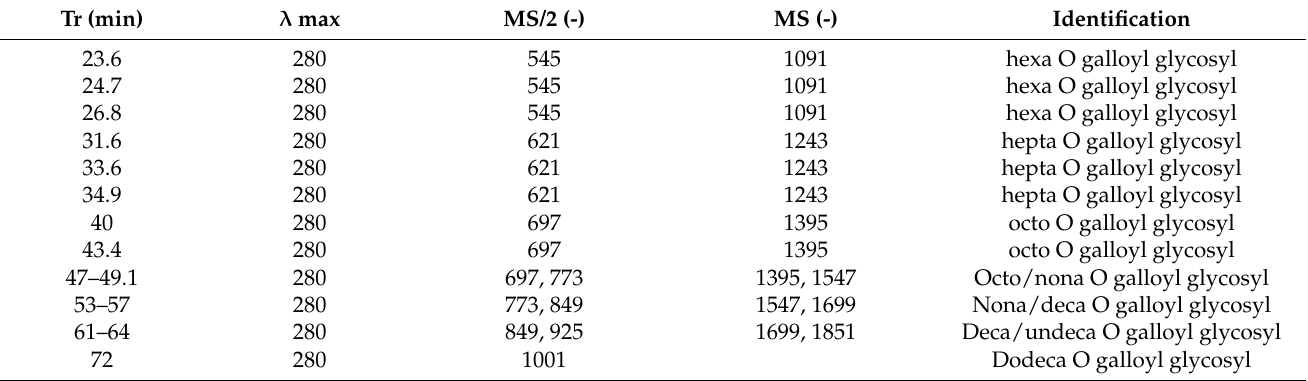
Figure 2. Identification of gallotannins in the peel of cv. ‘Cogshall’ mango measured at 280 nm. Table 2. Identification of gallic tannins in the peel of cv. ‘Cogshall’ mango obtained by